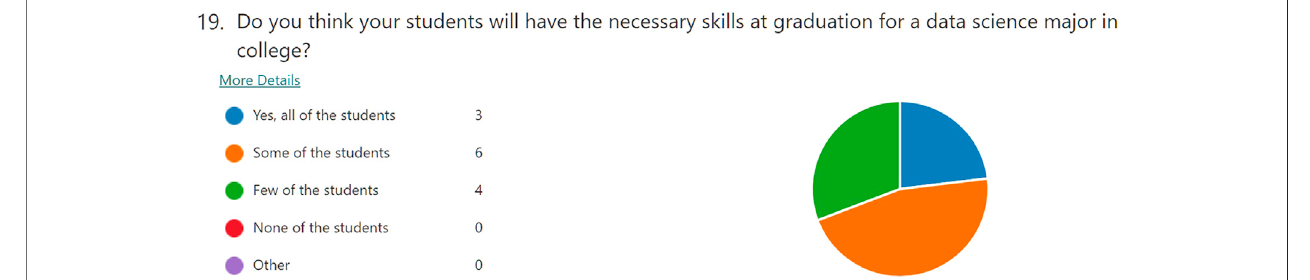
FIGURE 2 | Teacher Responses to the question asking if schools are equipped to teach data science.